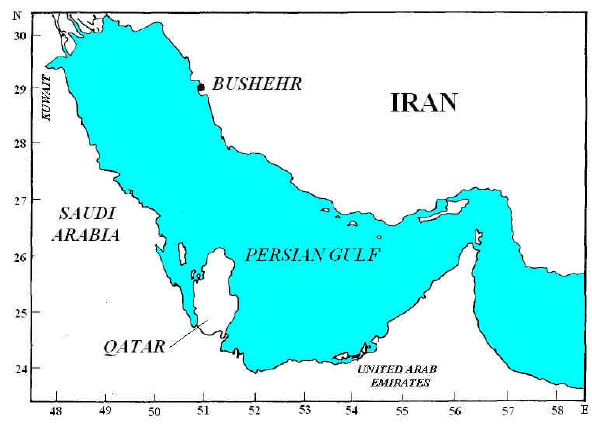
Figure1. Persian Gulf map (Ramesht 1988)